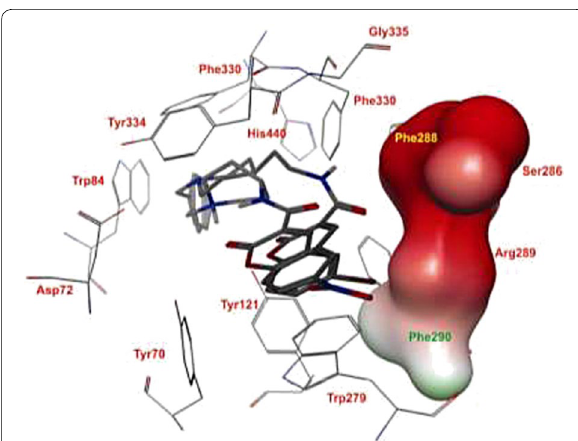
Fig. 20 The relative orientation of carboxamide linker of the best docking poses of C13a and C14a . The carboxamide linker of C14a oriented to a hydrophillic pocket (red surface) of the active site